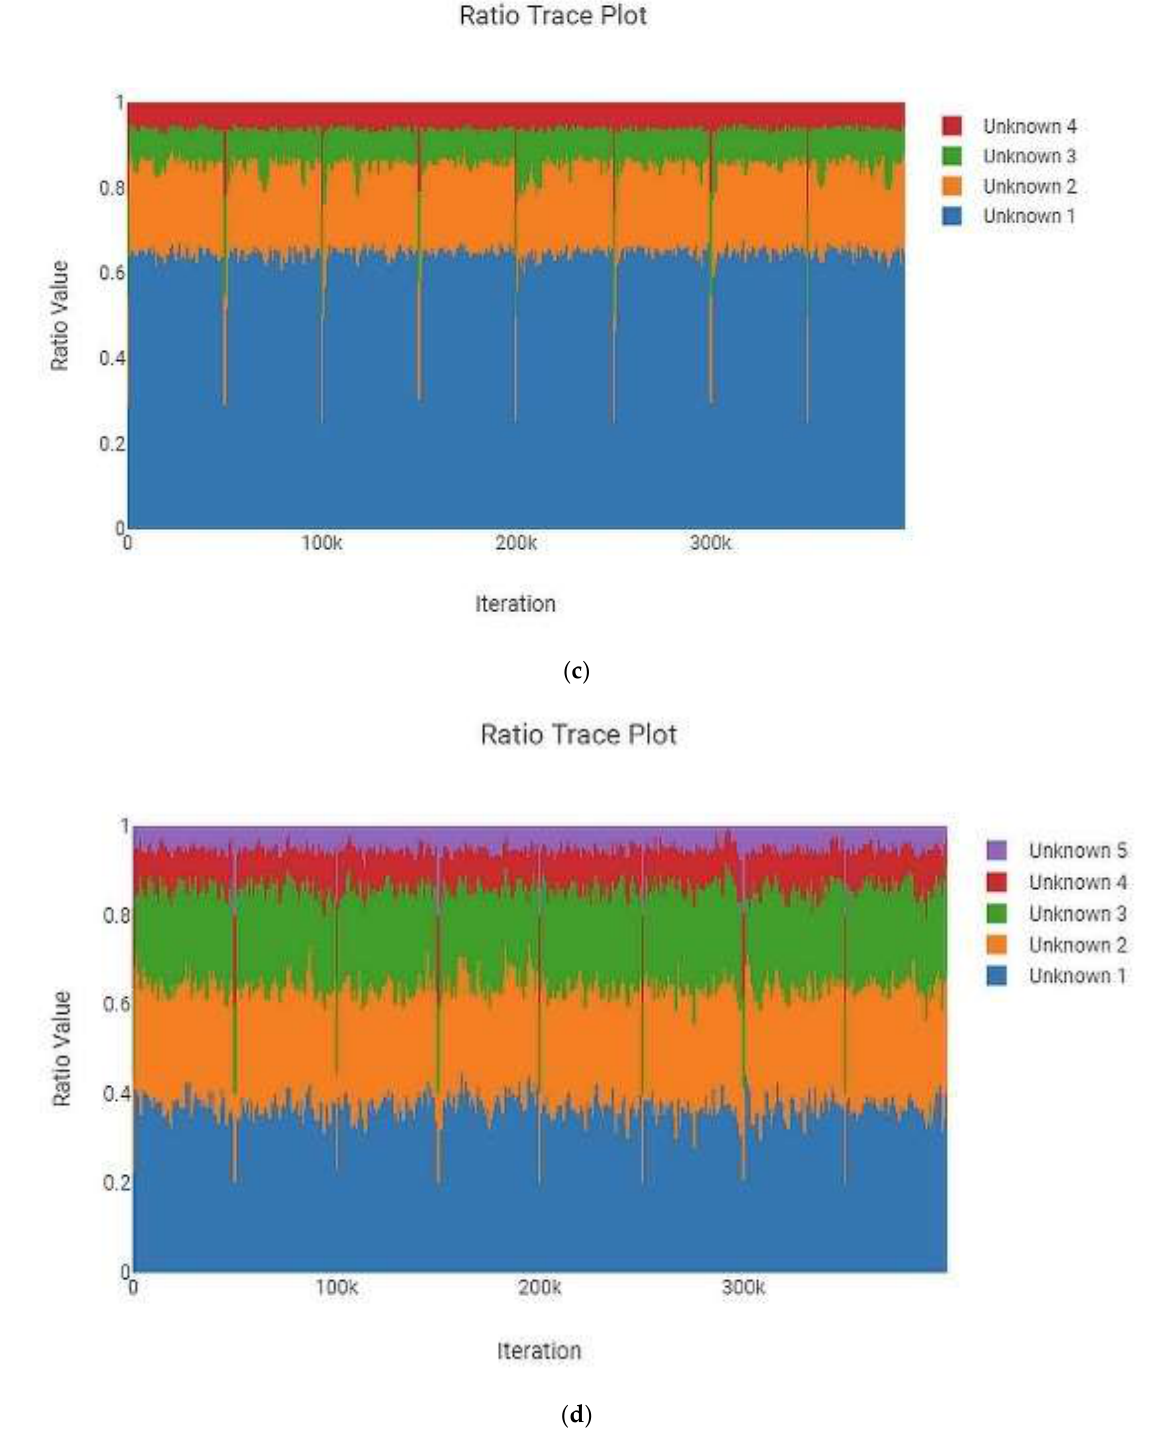
Figure 2. MaSTR™-generated ratio trace plots show a graphical representation of the calculated amount of each contributor to the mixture using the peak heights as determined from the modeled combinations of alleles in the most likely genotypes. The software defaults to numbering the unknown contributors (reference and alternates) from most abundant to least. The mixture ratios shown are ( a ) two-person 1:1, ( b ) three-person 1:1:2, ( c ) four-person 1:1:3:10, and ( d ) five-person 1:1:5:5:10. All data shown are from analyses using the highest number of MCMC iterations for the number of contributors.